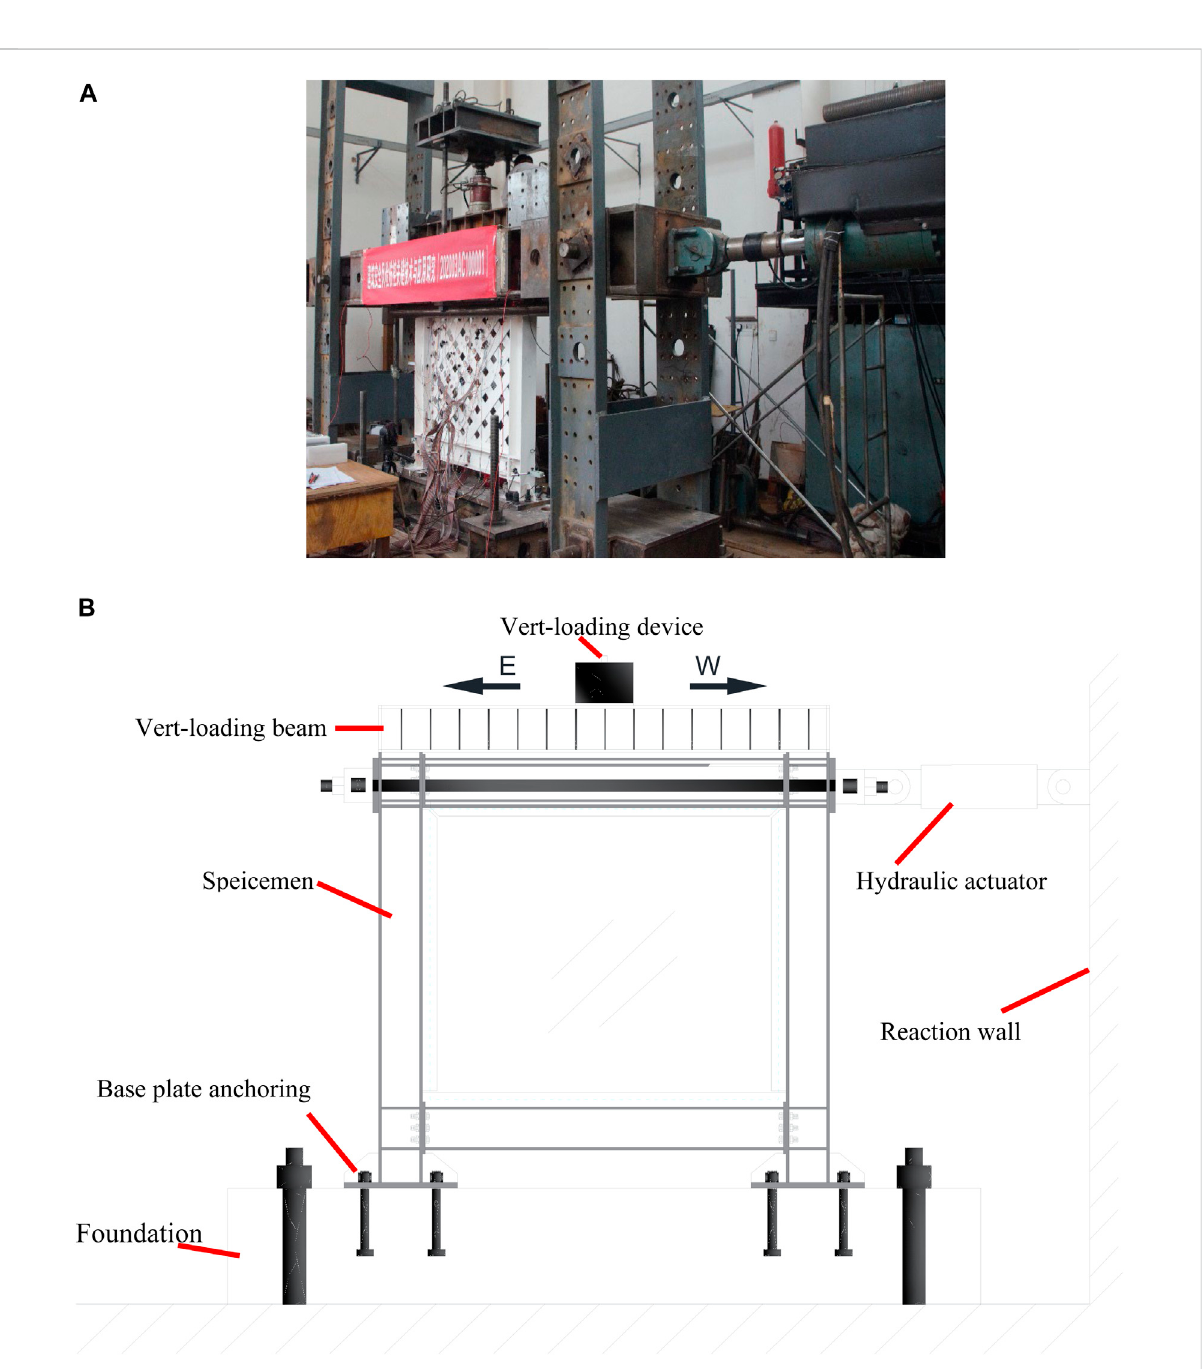
FIGURE 4 IWS-SPSW Test setup photo and con fi gurations: (A) IWS-SPSW Test setup photo, (B) Test setup con fi gurations.